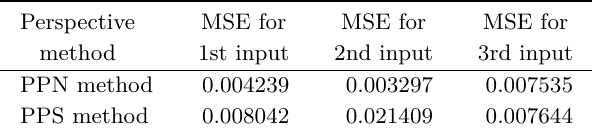
MSE comparison for the reprojected Beethoven images using PPN and PPS perspective methods